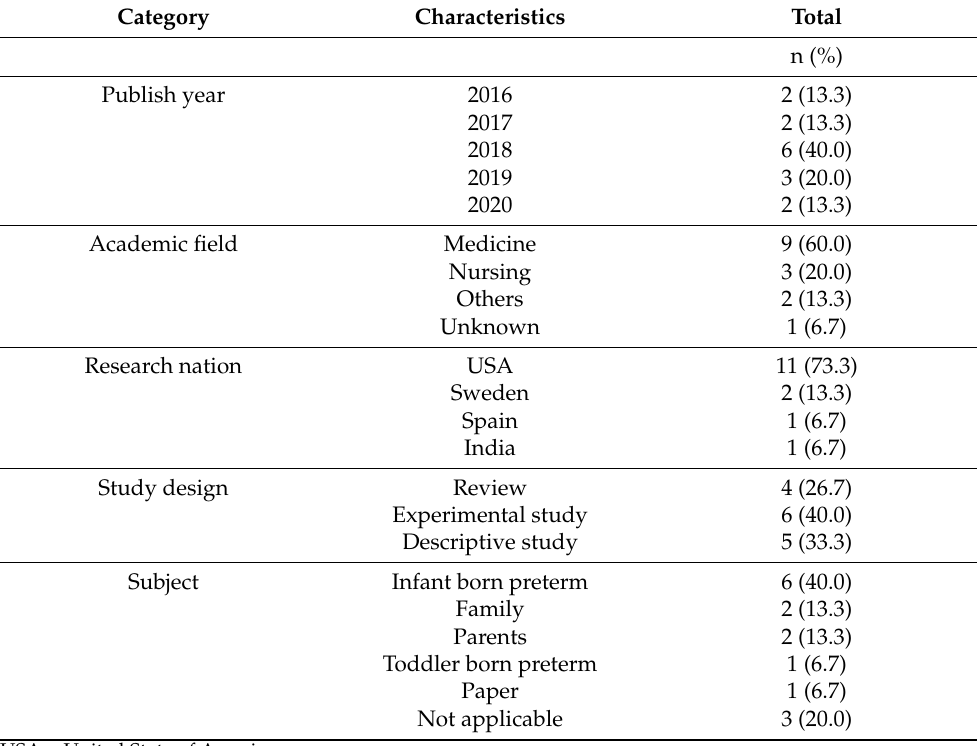
Table 1. General characteristics of reviewed studies (n = 15). Category